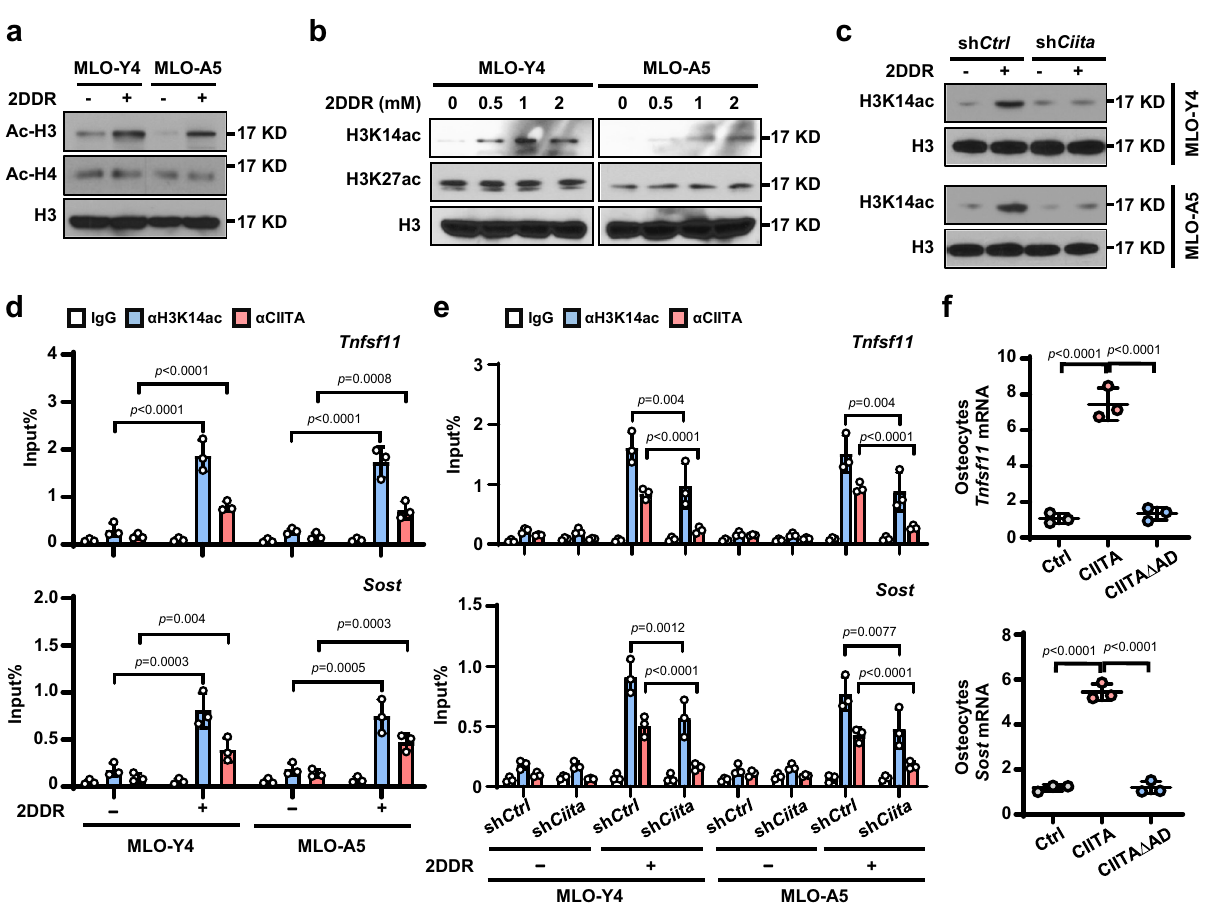
Fig. 5 CIITA mediates 2DDR-induced histone acetylation at H3K14 in the promoter of Tnfsf11 and Sost genes in osteocytes. a - b Western blot shows the acetylation levels of total histone H3 (Ac-H3) and H4 (Ac-H4) ( a ) and of histone H3 lysine 14 (H3K14ac) and lysine 27 (H3K27ac) ( b ) in MLO-Y4 or MLO-A5 osteocytes cultured without or with 1 mM 2DDR. H3 levels served as controls. c Western blot analysis shows the levels of H3K14ac in sh Ctrl or sh Ciita MLO-Y4 or MLO-A5 cells cultured without or with 1 mM 2DDR. H3: loading control. Data shown in a – c are representative of two independent experiments. d ChIP assay shows the enrichment of H3K14ac or CIITA in the promoter of Tnfsf11 or Sost genes in MLO-Y4 or MLO-A5 cells cultured without or with 1 mM 2DDR. Data are mean ± SD (n = 3 biological replicates). e ChIP assay shows the enrichment of H3K14ac and CIITA in the promoter of Tnfsf11 or Sost genes in sh Ctrl or sh Ciita MLO-Y4 or MLO-A5 cells cultured without or with 1 mM 2DDR. Data are mean ± SD (n = 3 biological replicates). f Shown is the relative expression of Tnfsf11 or Sost in primary osteocytes that were transfected with wild-type CIITA cDNA or CIITA Δ AD (dominant- negative mutant that lacks the HAT activation domain). P values were determined using one-way ANOVA with Tukey ’ s multiple comparisons